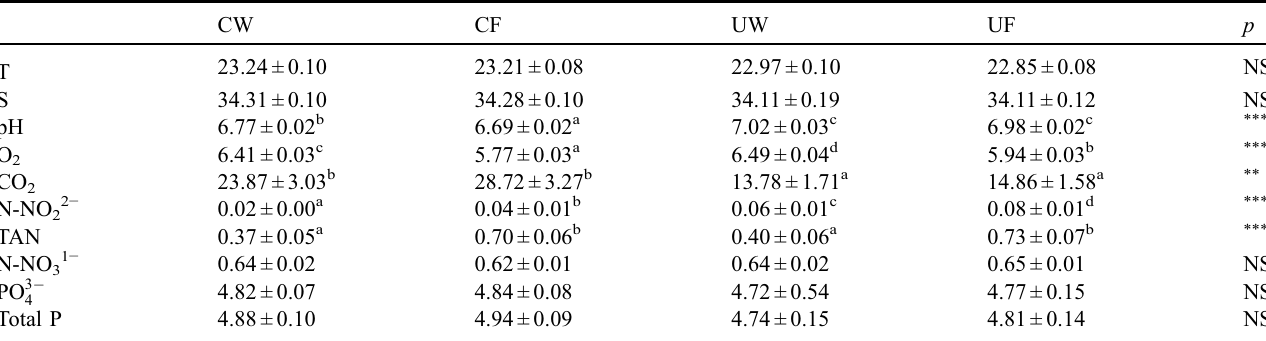
Table 1. Mean values (±SE) of temperature ( ° C), salinity, pH, dissolved oxygen and carbon dioxide from daily measurements during the 12-week trial, as well as mean values (mg L (cid:1) 1 ) of total ammonia, nitrite, nitrate, orthophosphates and total phosphorus for samples collected twice per